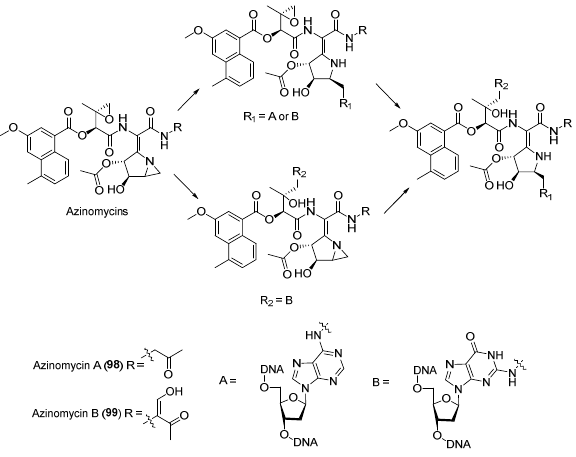
Figure 12. Proposed mechanism of DNA cross-linking by azinomycins.